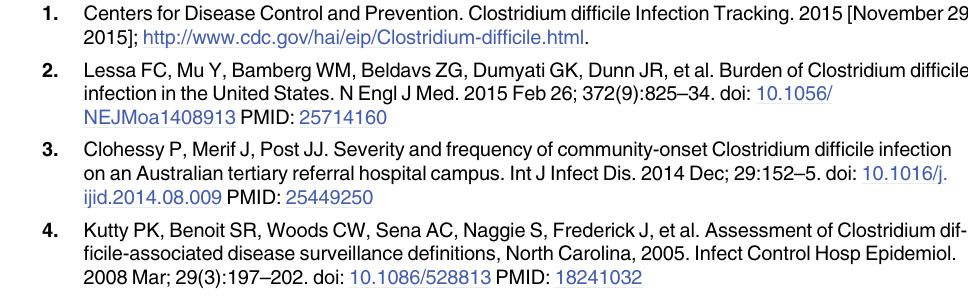
S4 Table. Selected details on the re-matched infected subjects who died. a Measured at the index date. b Highest resource utilization band measured within the previous two years before the index date (Adjusted Clinical Groups 1 were used to measure comorbidities- see S3 Table). CDI– C . difficile infection. NA—not applicable. SD—standard deviation. S5 Table. Overall and stratified mean attributable costs per subject. Confidence intervals not reported, however, none of the confidence intervals crossed zero. CDI—C. difficile infec- tion. NA—not